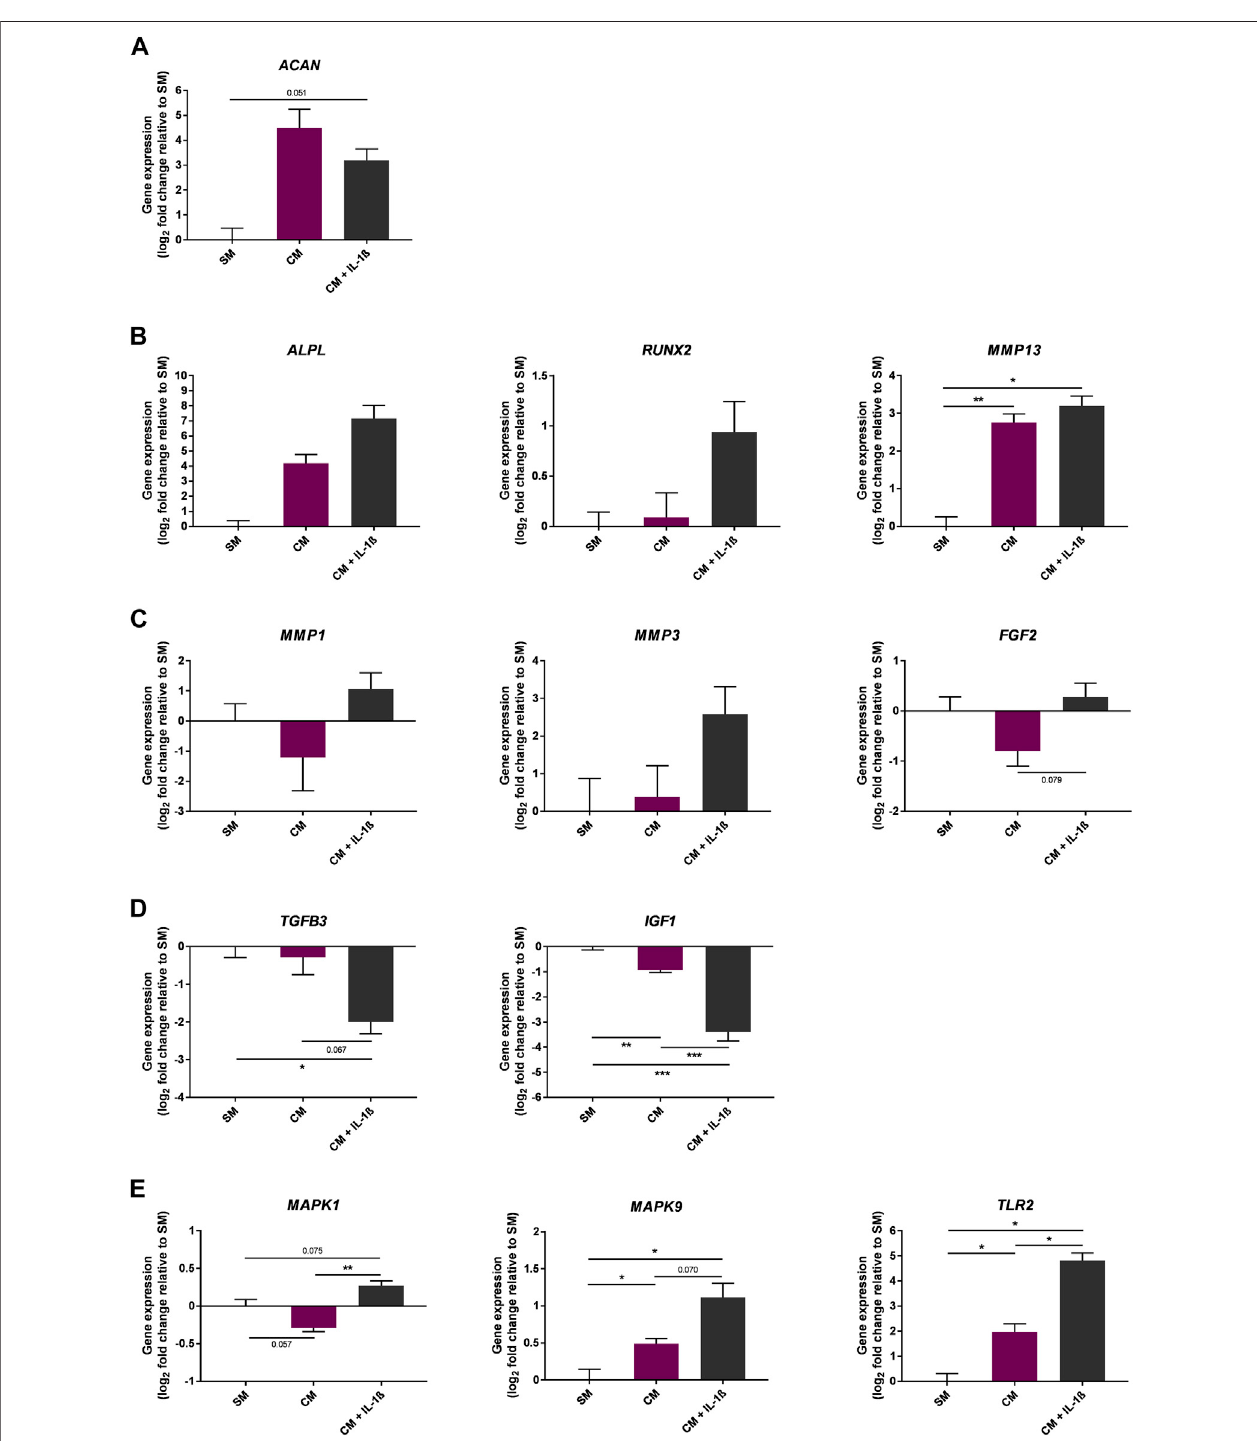
FIGURE 7 | Gene expression changes in response to IL-1 β (100 pg/ml) added to MSC cultures in CM over 10 days. Gene expression of chondrogenic (A) and chondrogenic hypertrophy (B) markers, catabolic (C) and anabolic (D) markers, and MAPK enzymes and toll-like receptors (E) . Data shown as log 2 fold change compared to SM control condition. Error bars represent SEM. n = 3, * p < 0.05, ** p < 0.01, *** p < 0.001.